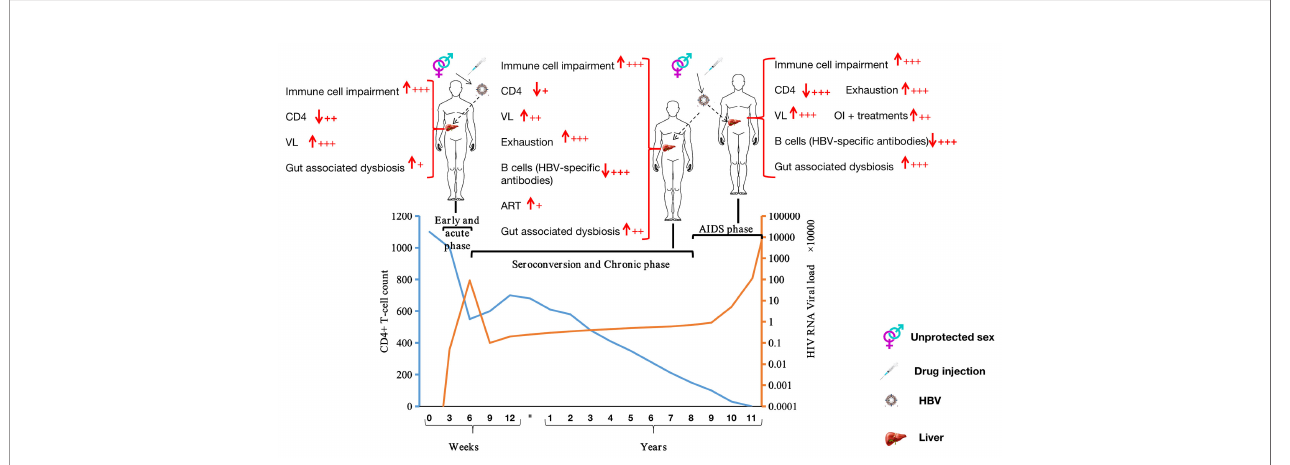
FIGURE 2 | Stages of HIV infection and factors potentially favoring HBV infection at each clinical stage of HIV infection. ↓ : depletion; ↑ : augmentation; VL, viral RNA load; OI, opportunistic infection; +: Mild; ++: Moderate; +++: Severe.